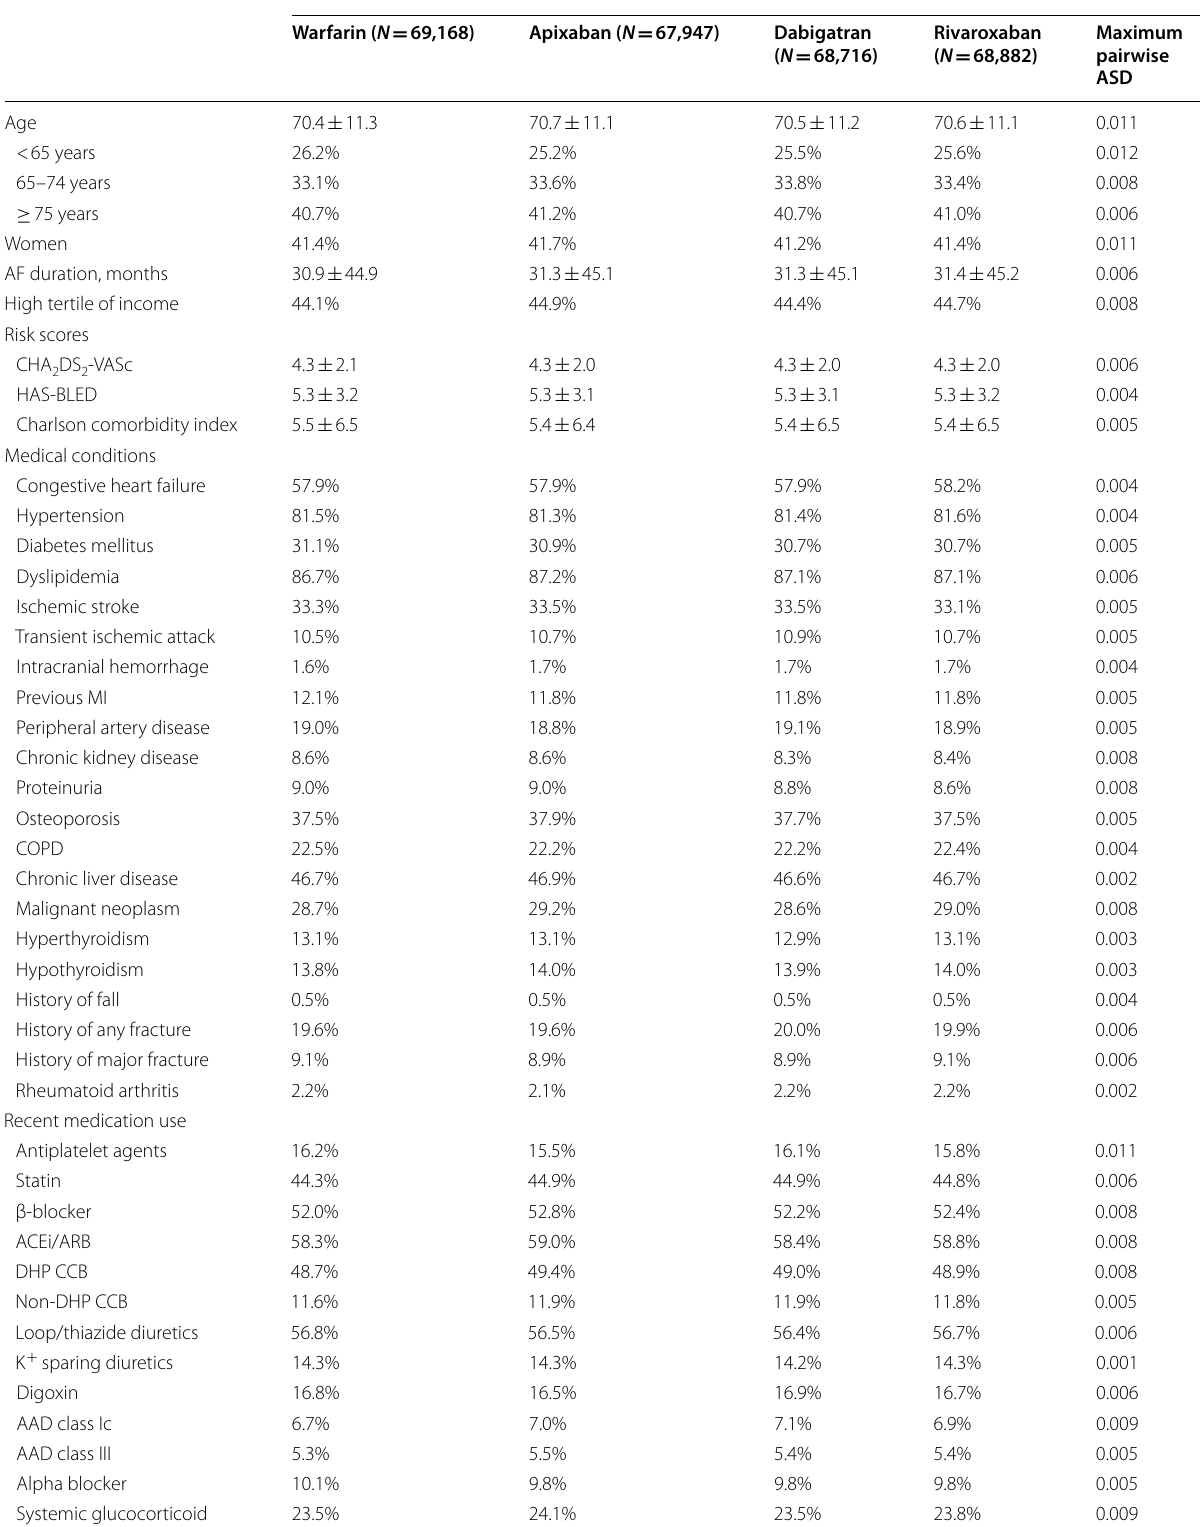
Table 2 Baseline characteristics after inverse probability of treatment weighting